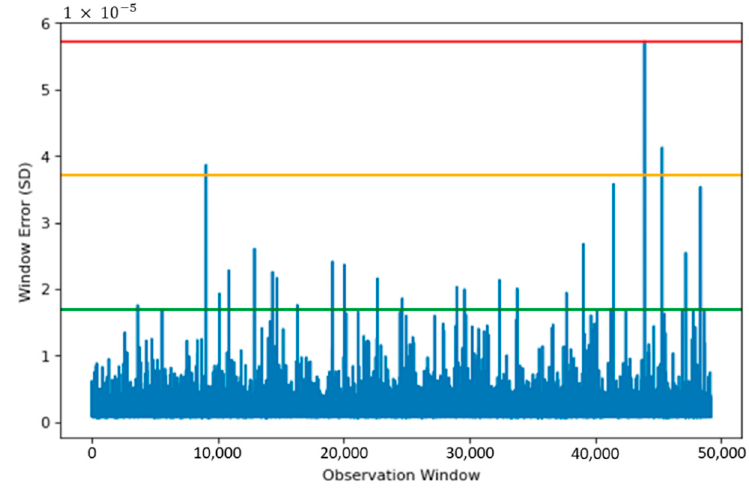
Figure 7. Reconstruction plot using SAE model, on known healthy data, using MSE as the indicator. Red line denotes the upper threshold based upon the 99.99 percentile error from our model. Green threshold is based upon the 99.95 percentile. Orange threshold is the region between the two thresholds.